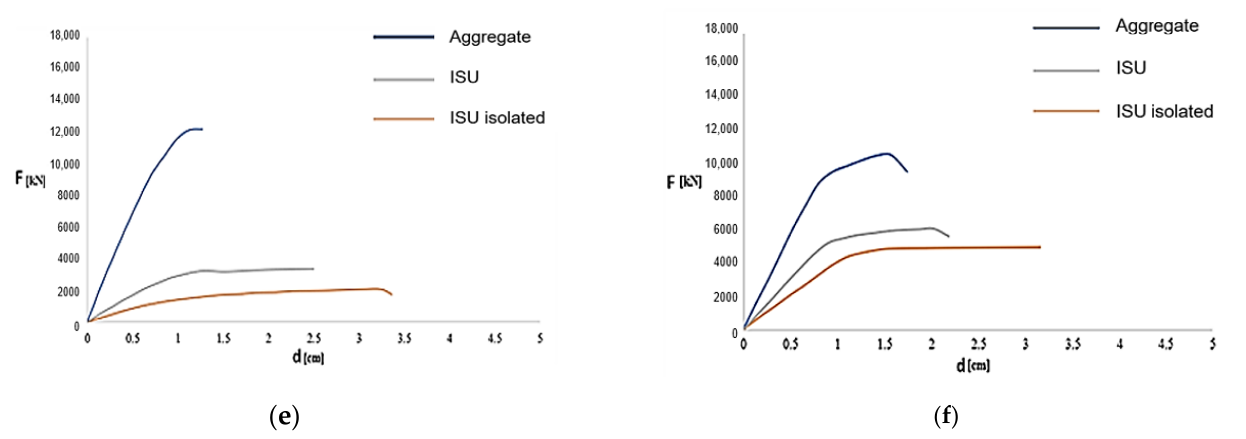
Figure 10. Pushover curves of the worst analysis scenarios for the whole aggregate ( a , b ), the intermediate structural units in aggregate (ISU) ( c , d ), and the isolated (ISU isolated) ( e , f ) configurations.